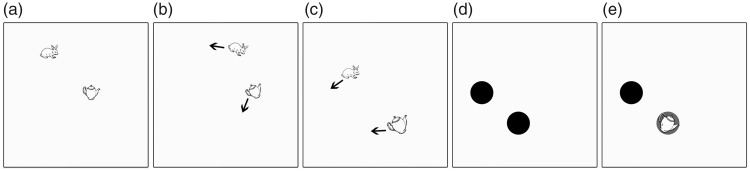
Example of a trial in Experiment 6. First, targets were assigned
(a), then all objects started moving around the display while
frequently rotating 30° left and right (b), a change in size
occurred (larger or smaller) at a random time point between 2
and 6 seconds from start of tracking (c; notice that the teapot
increases in size). The movements stopped once a total of 8
seconds had elapsed or the observer pressed a button. The
objects were immediately occluded behind black disks as the
movements stopped (d). Participants then indicated the location
of the changed object (e). Image of rabbit adapted with
permission (Snodgrass & Vanderwart, 1980, pp. 197–204).